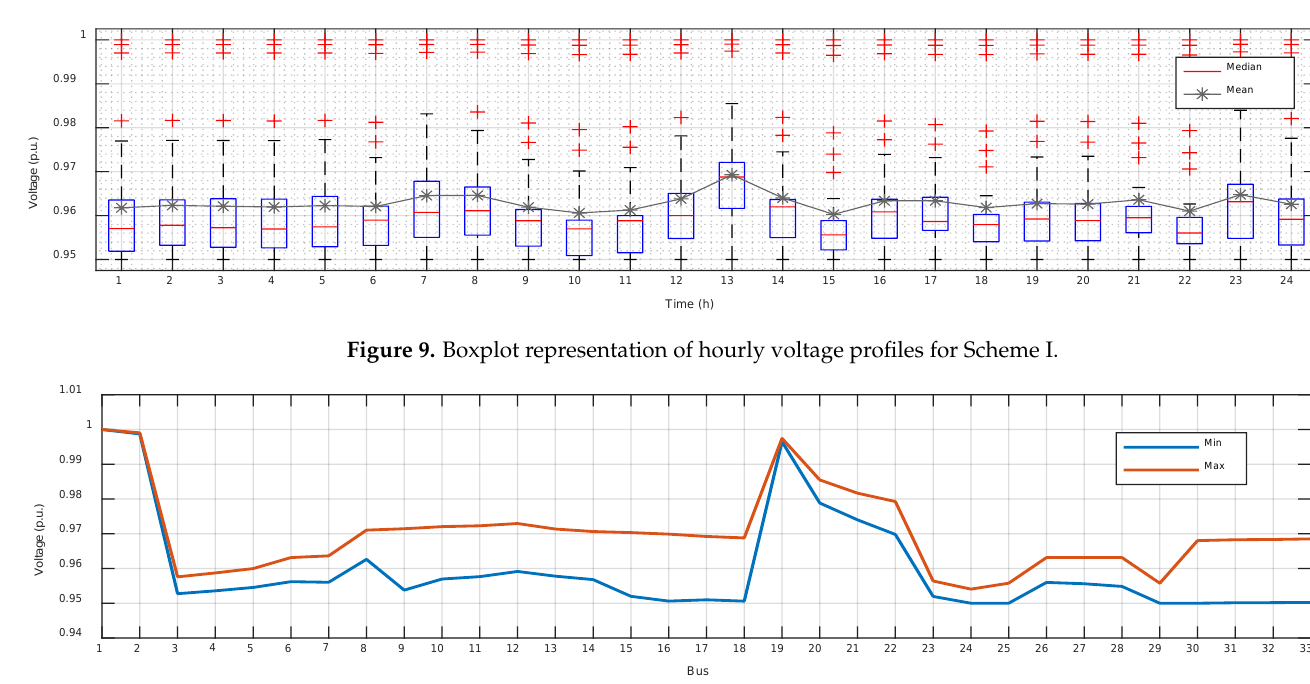
Figure 10. Minimum and maximum bus voltages for Scheme I.